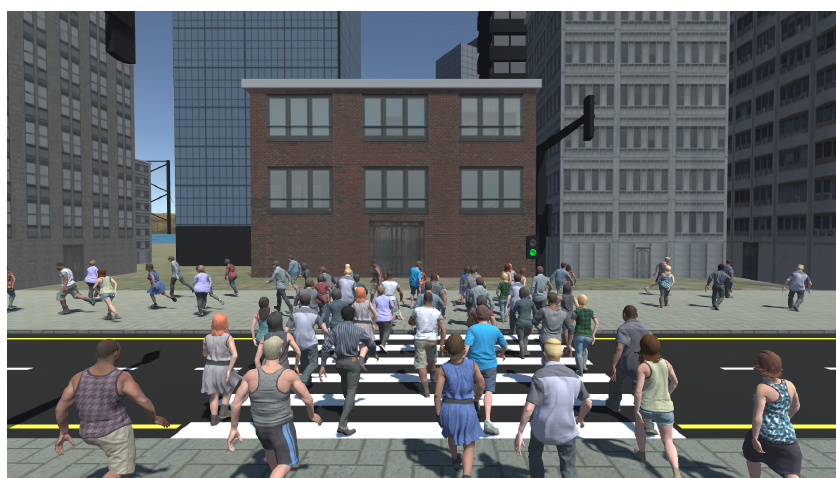
Figure 1. The virtual crosswalk used in this study and the virtual crowd that was scripted to move toward the opposite sidewalk.